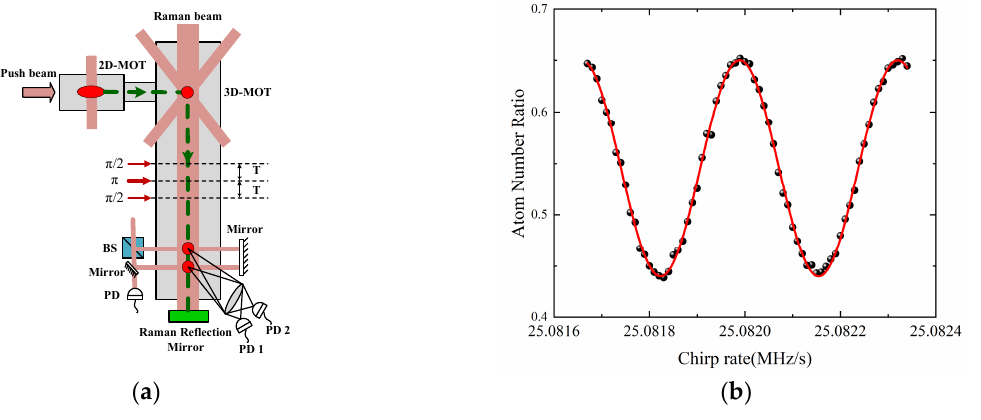
Figure 2. The measuring principle of CAG atomic gravimeter. ( a ) The working principle of gravity sensor head; ( b ) the cold atom interference fringes obtained in the